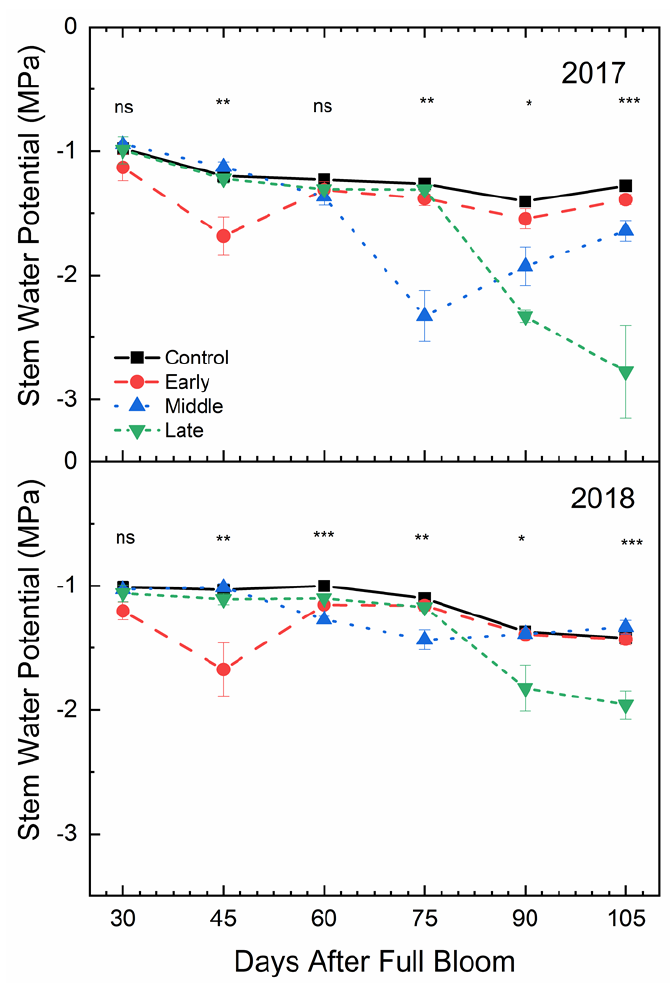
Figure 6. Mean mid-day stem water potential ( ± SE; n = 3) of ‘Honeycrisp’ apple under deficit irrigation in 2017 (bottom) and 2018 (top). Four treatments were established including a well-watered control (squares), early season deficit (16–45 days after full bloom [DAFB]; circles), mid-season deficit (46–75 DAFB; triangles), and late season deficit (76–105 DAFB; inverted triangles). Symbols denote significance among treatments at each measurement date (ns = not significant, * p ≤ 0.05, ** p ≤ 0.01, *** p ≤ 0.001) .